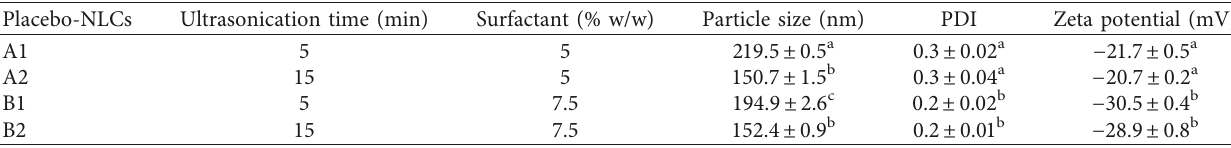
Table 6: Mean particle size, polydispersity index (PDI), and zeta potential of NLCs with different ultrasonication time and surfactant